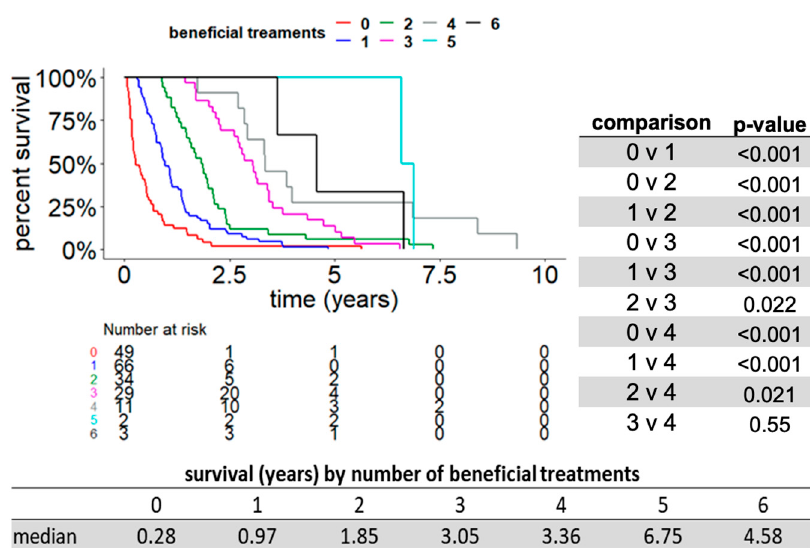
Figure 4. A greater number of beneficial therapies received correlated with longer OS. Kaplan–Meier OS curves for patient cohorts defined by the total number of beneficial lines of treatment received (independent of total number or duration of treatments). Subpanel: Pairwise statistical comparison of the duration of OS between the five subgroups receiving zero, one, two, three, and four beneficial lines of therapy.